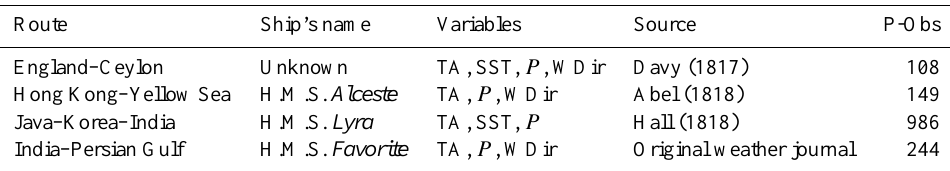
Figure 1. Position of the land observatories (red dots) and routes of the ships. For the latter, filled symbols denote locations for which pressure data are available, colours indicate time for marine data. The inset map shows the positions of the European observatories and of additional locations mentioned in Sect. 3. Table 2. Ships’ logbooks included in the collection. Abbreviations: P-Obs: number of pressure observations; TA: air temperature; SST: sea surface temperature; P : air pressure; WDir: wind